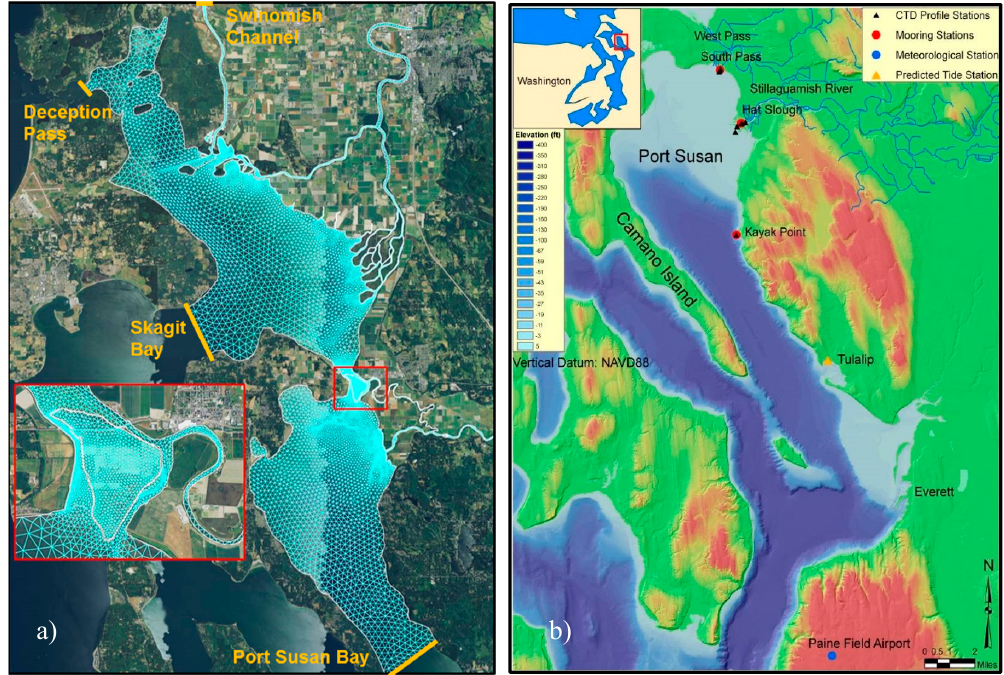
Figure 2. ( a ) Baseline model grid of the Skagit and Stillaguamish River estuaries including Skagit Bay, Port Susan Bay, and the Leque Island and zis a ba. The inset shows detail the Leque Island and zis a ba project sites. ( b ) Oceanographic observation stations at Port Susan Bay, October 2005.